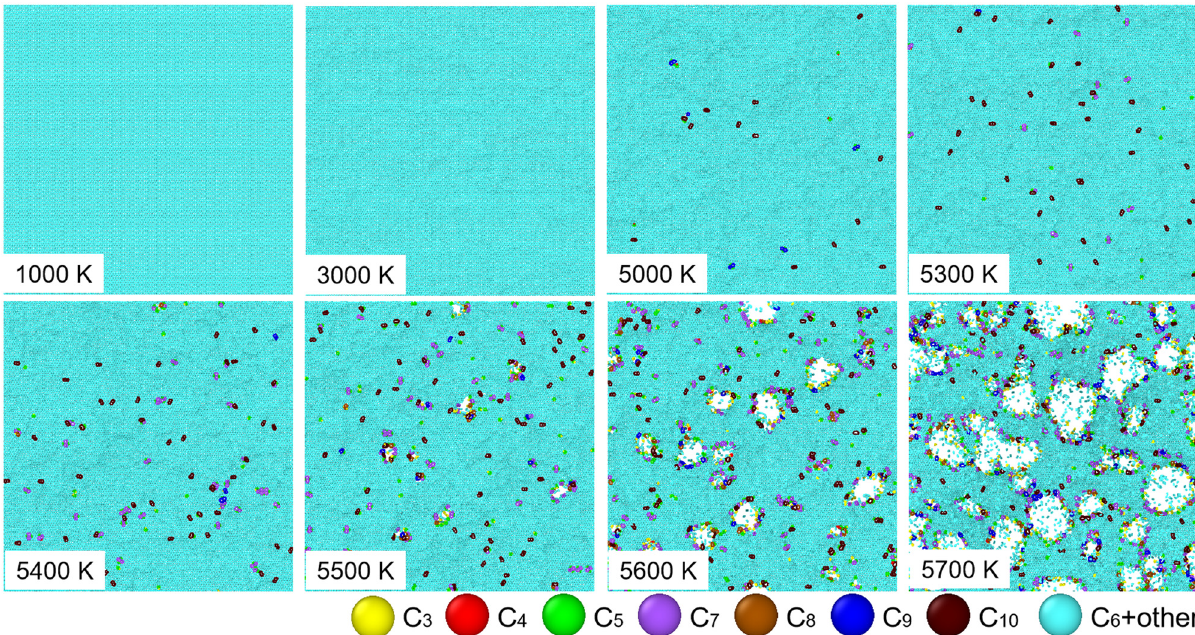
Figure 5: Top views of atomic structure of 2D graphene subjected to heating at eight di ff erent T . For enhanced observation of the thermally induced structural transformations, carbon atoms belonging to di ff erent polygonal rings from trigon to decagon are color -